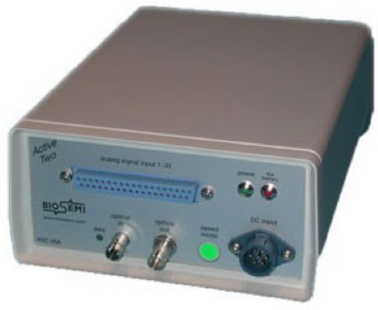
Figure 3. The BioSemi Active 2 A/D simultaneous conversion unit; 32 ‐ channel analogue input.